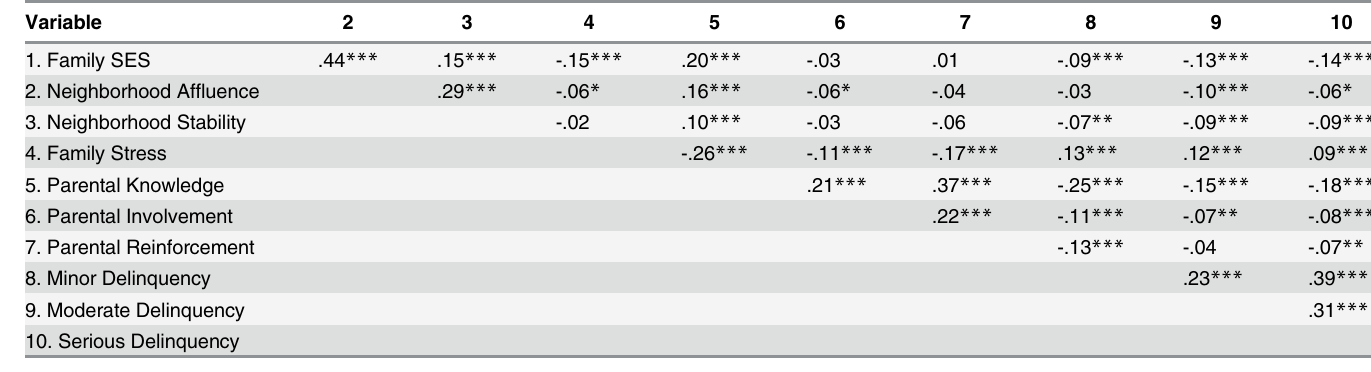
Table 2. Bivariate Correlations (Pearson ’ s R). Note . Estimates across observations with standard errors adjusted for clustering within respondents. The first three waves are excluded due to a low prevalence of delinquency. Correlations between different types of delinquency are the square root of a logistic regression analysis ’ pseudo R 2 (row variable regressed on column